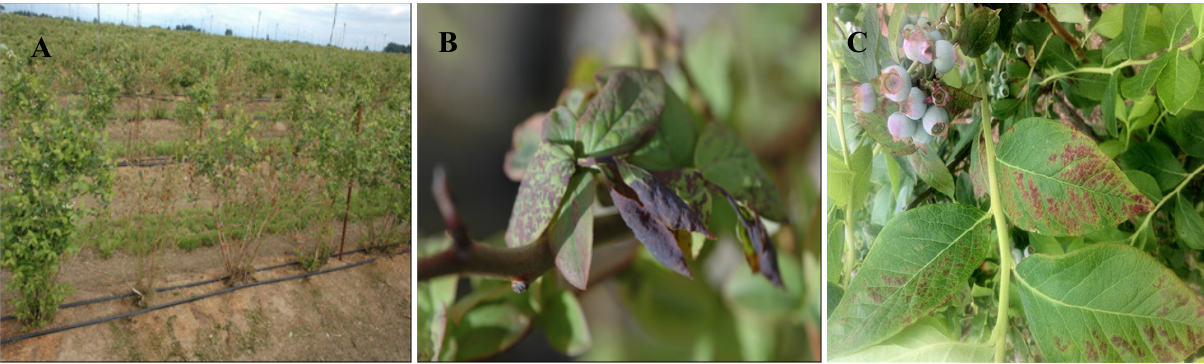
Figure 3. Blueberry shock virus symptoms: ( A ) Leaf and flower necrosis in cv. ‘Liberty’ showing many symptomatic and asymptomatic bushes in a production field; ( B ) Close up of leaf necrosis in cv. ‘Bluegold’; and ( C ) Leaf reddening in recovered plants that has been observed in several cultivars in years with prolonged cool conditions in